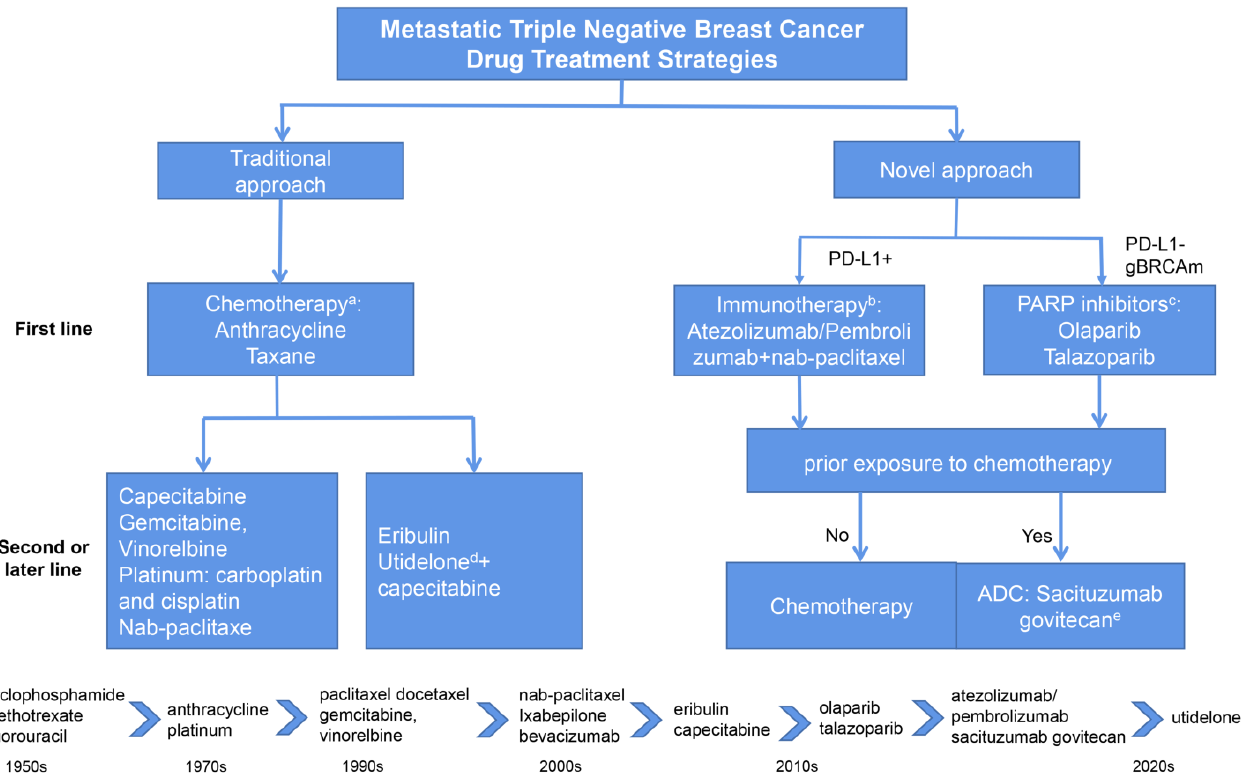
Figure 2. The brief history of the development of drugs and current therapeutic strategies approved for mTNBC. mTNBC: metastatic triple-negative breast cancer; PARP: poly (ADP-ribose)